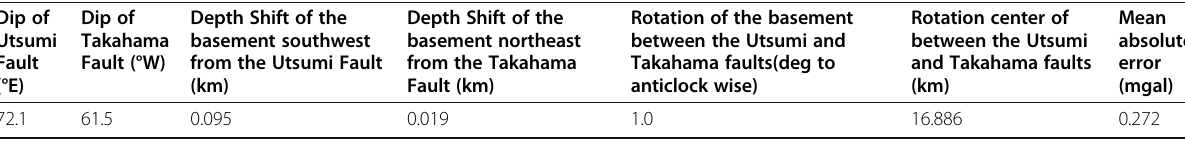
Table 2 Optimum parameters for the 2D basement model Dip of Dip of Utsumi Takahama Fault Fault (°E)